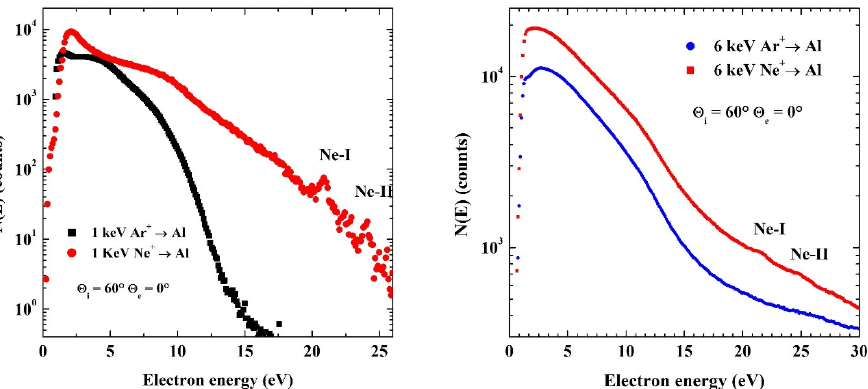
Figure 3. Energy spectra N(E) of electrons emitted from an Al surface by 1 keV ( left ) and 6 keV ( right ) Ne+ and Ar+ ions for an incident angle of 60° and observation angle 0° (spectra acquired with the angle resolved spectrometer).